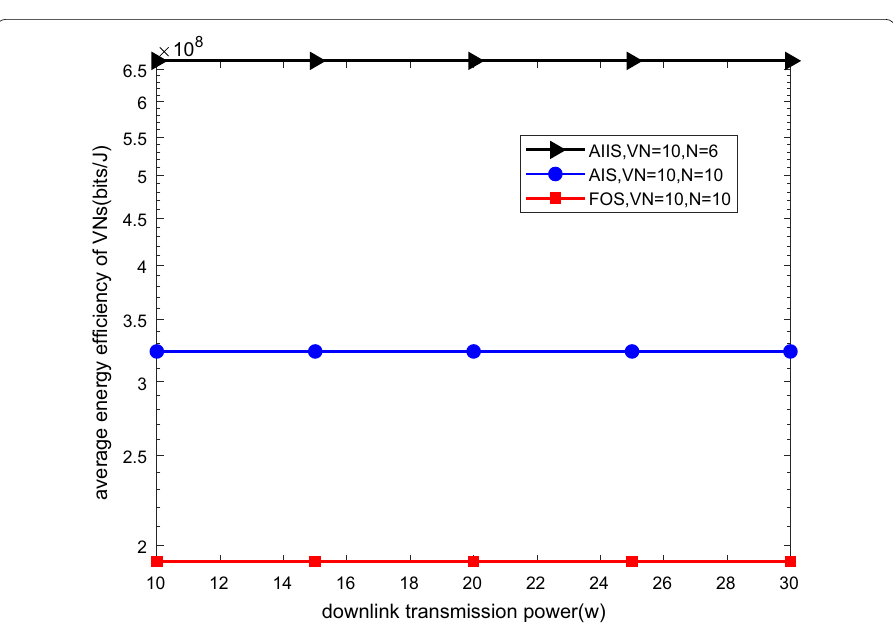
Fig. 6 The average energy efficiency of vehicle nodes (VNs) versus the different transmitting power of